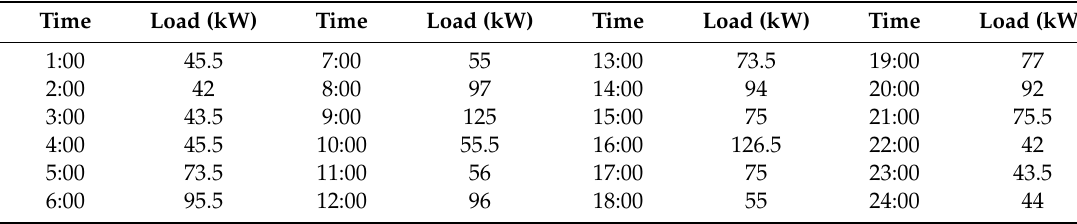
Table 5. Typical daily load of an agricultural user.